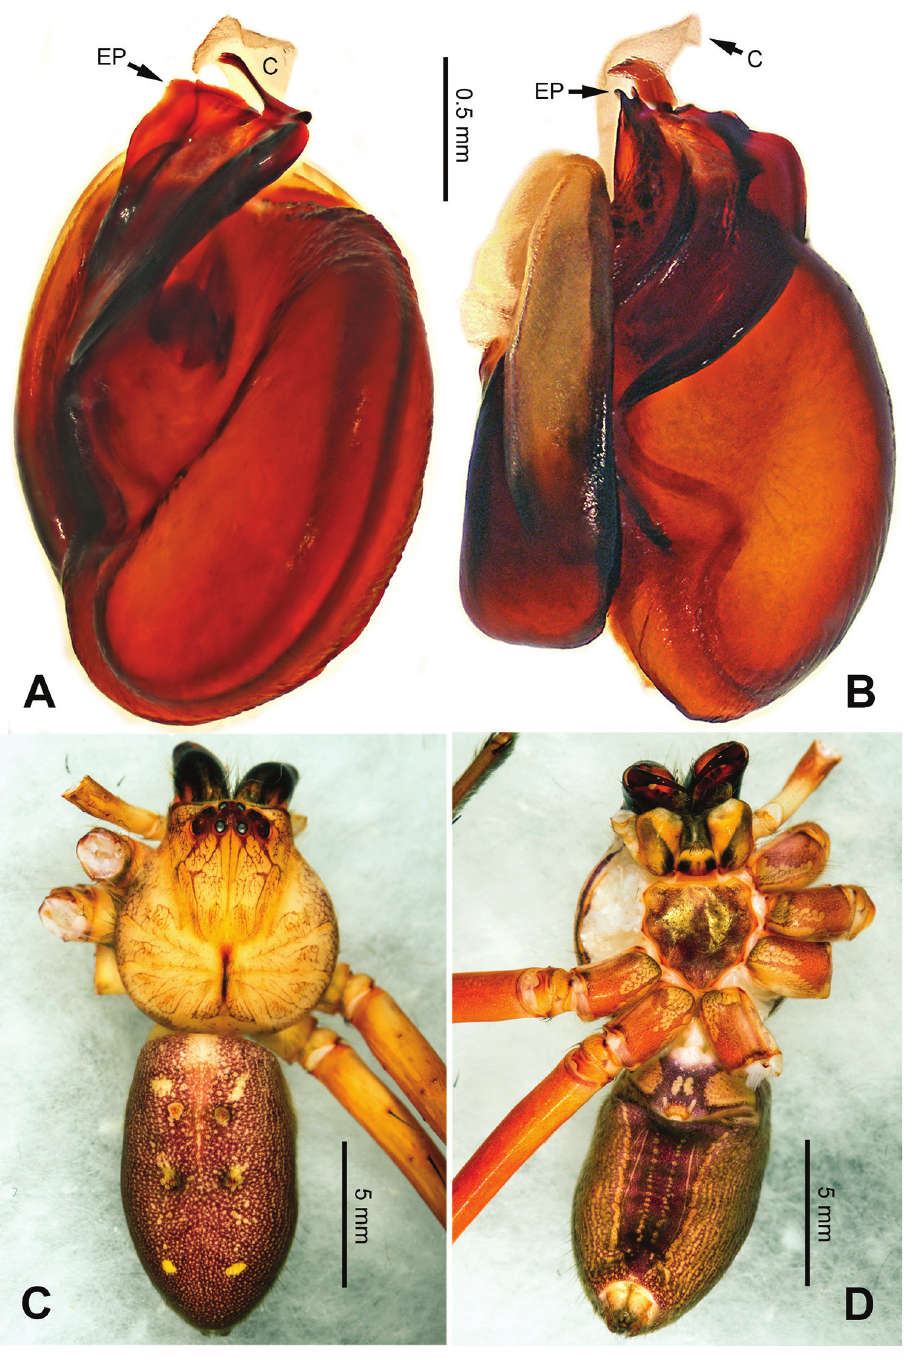
Figure 29. Pseudopoda titan Zhao & Li, sp. n., male holotype. A Bulb, ventral view B Bulb, dorsal view C Habitus, dorsal view D Habitus, ventral view. Scale bar equal for A, B